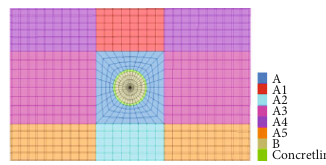
Figure 10: Tunnel grid.